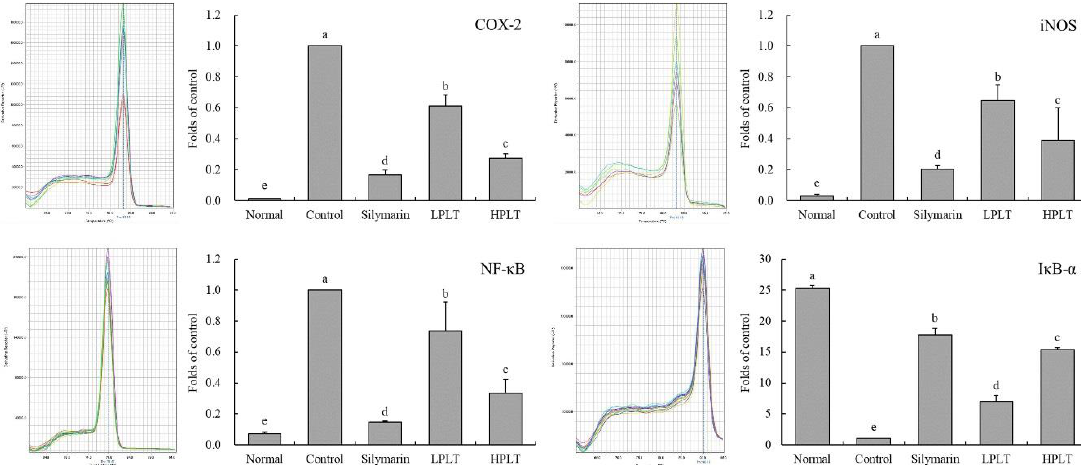
Figure 4. Cyclooxygenase 2 (COX-2), inducible nitric oxide synthase (iNOS), nuclear factor κ -light-chain-enhancer of activated B cells (NF- κB ), and nuclear factor of κ -light polypeptide gene enhancer in B-cells inhibitor- α ( IκB - α ) mRNA expressions in hepatic tissue of experimental mice with CCl 4 -induced hepatic damage. Values presented are the means ± standard deviation ( N = 3/group). a – e Mean values with different letters in the same bars are significantly different ( p < 0.05) and those with the same letter in the same column are not significantly different ( p > 0.05) according to Duncan’s new MRT. Silymarin group: 50 mg/kg b.w. silymarin treatment dose; LPLT group: 50 mg/kg b.w. polyphenols of Liubao tea (PLT) treatment dose; and HPLT group: 100 mg/kg b.w. polyphenols of Liubao tea (PLT) treatment dose.